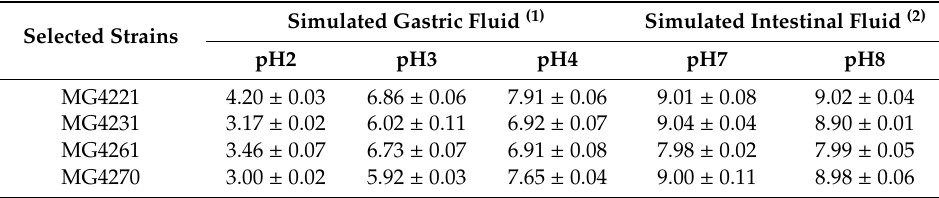
Table 1. Survival of the selected Lactobacillus strains in simulated human gastrointestinal tract Table1. Survivaloftheselected Lactobacillus strainsinsimulatedhumangastrointestinaltractconditions. conditions. Selected